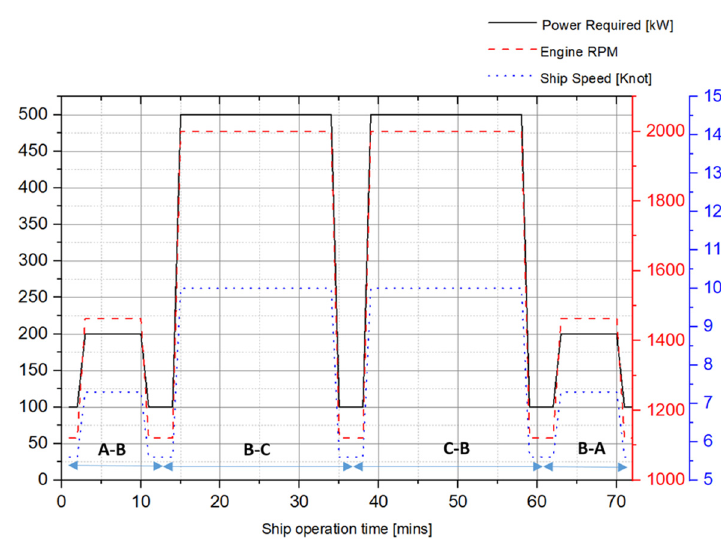
Figure 3. Engine power, rotation speed and operating time for each voyage.